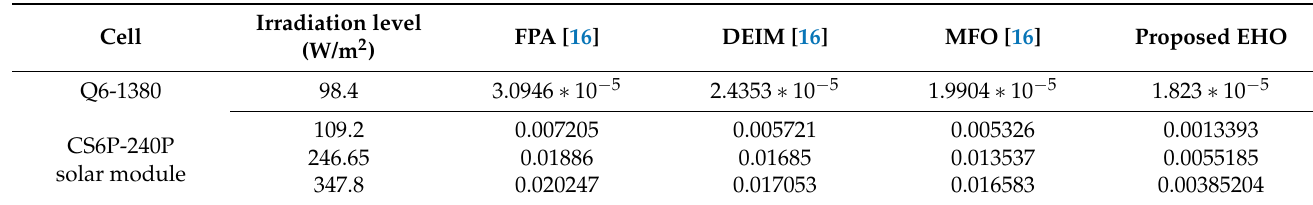
Table 8. Comparison of simulation results of EHO with corresponding results in the literature.